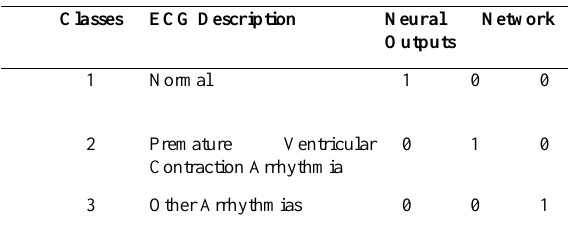
Table 1. ECG classes and representation of desired neural network outputs.